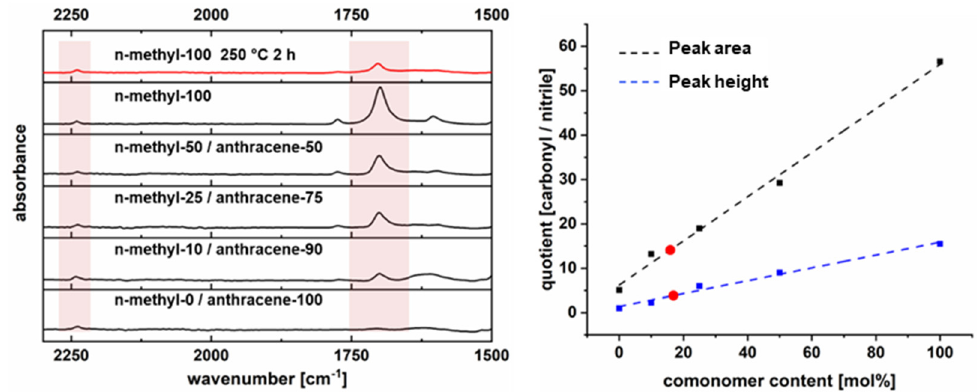
Figure 8. Quantification of conversion by means of FT-IR.